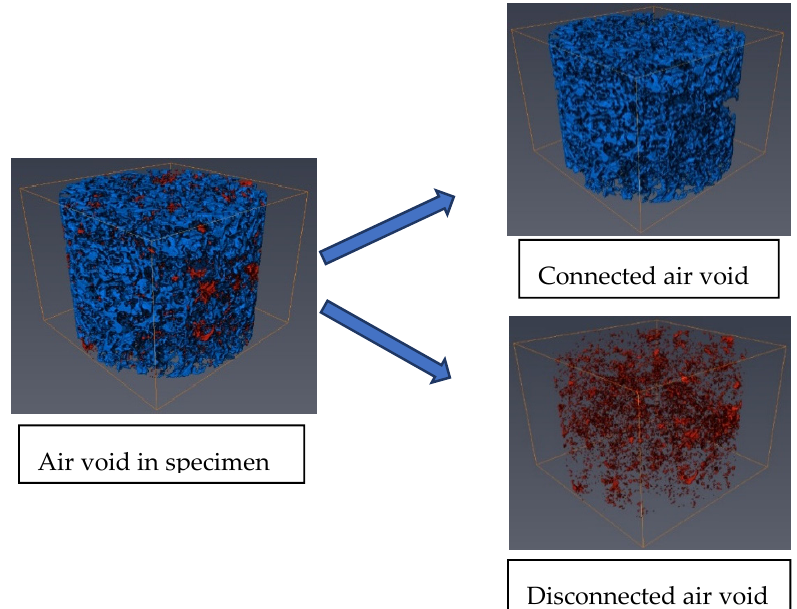
Figure 4. Visualization of connectivity and disconnectivity of the air void.